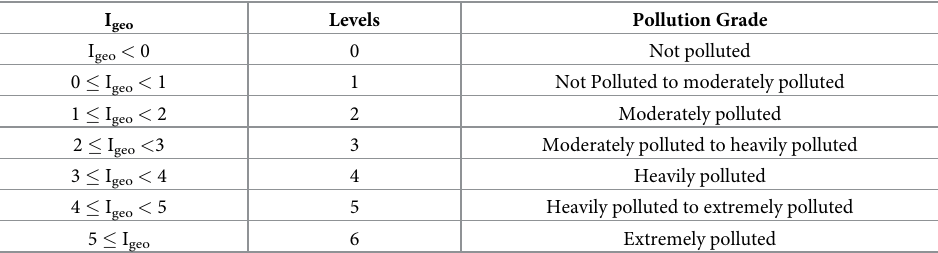
Table 3. Pollution grades of I geo .